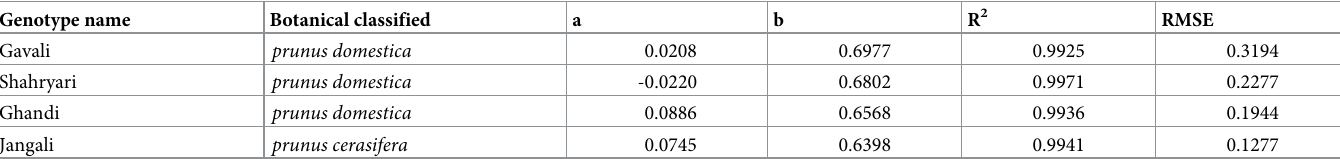
Table 5. The results of regression analysis for three greengages ( prunus domestica ) and a myrobalan plum ( prunus cerasifera ) genotypes to estimate the LA using the product of leaf length (L) and width (W) as independent variable [LA = a+b(L × W)] using collected data in 2021. Genotype name